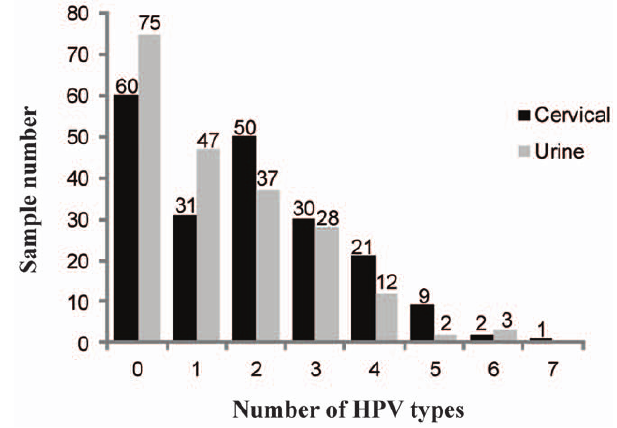
Figure 2. Number of HPV types in cervical and urine samples for 204 HIV-infected Colombian women.